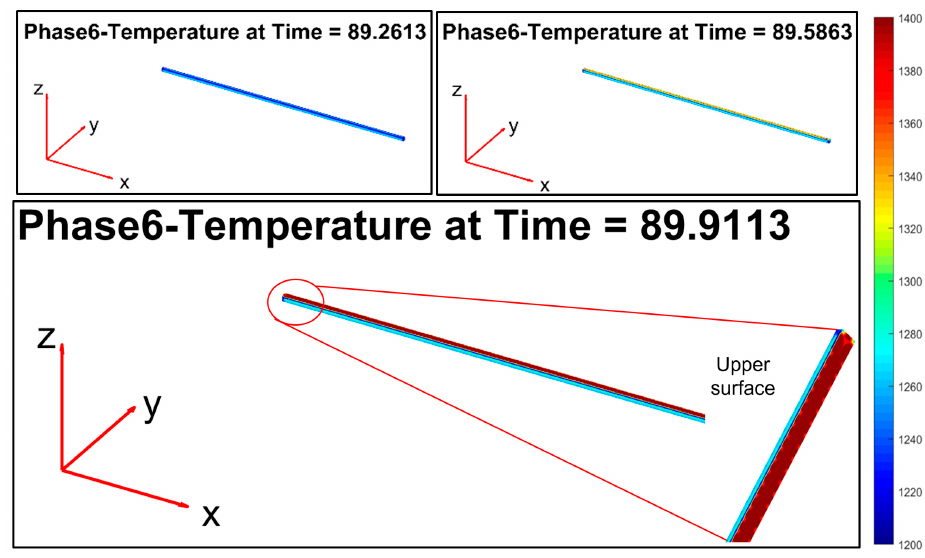
Figure 18. Modelization: phase 6 (processing between stand 3 and stand 9).